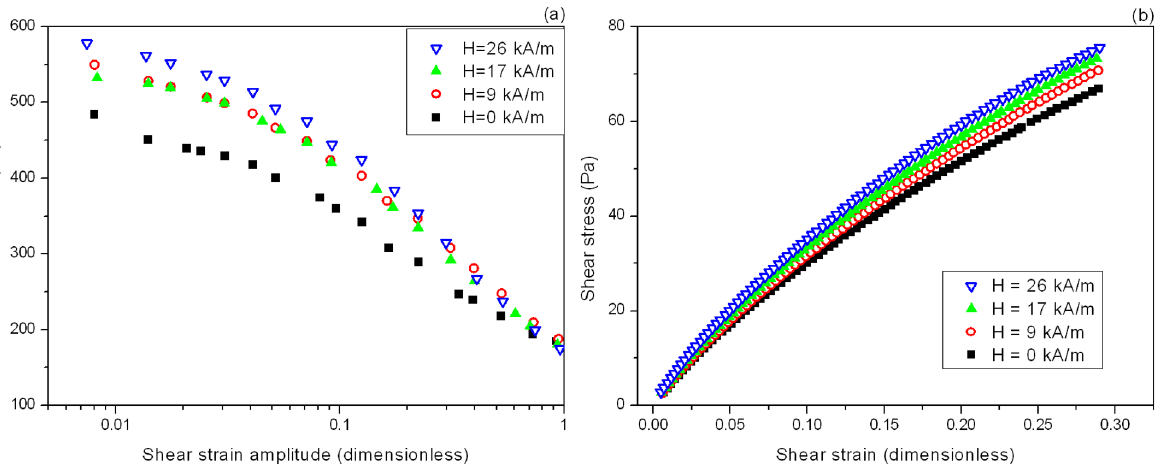
Fig 7. Effect of a magnetic field on the mechanical properties of magnetic tissue substitutes. Sample M-MF32 is a magnetic tissue substitute gelled during application of a 32 kA m -1 field. The effect of a magnetic field applied during measurement on the mechanical properties of the tissue substitute is shown as (a) the elastic modulus as a function of shear strain amplitude, and (b) the initial portion of the shear stress vs. shear strain curves. The intensities ( H ) of the magnetic field applied are shown.